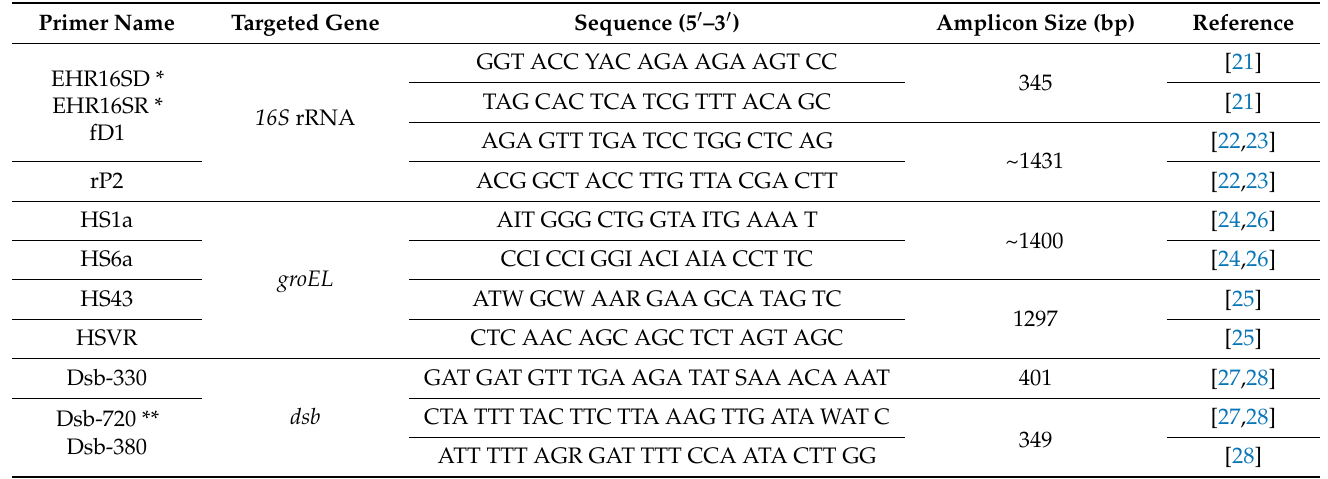
Table 1. PCR primers used to amplify the partial 16S rRNA, groEL , and dsb genes of Ehrlichia